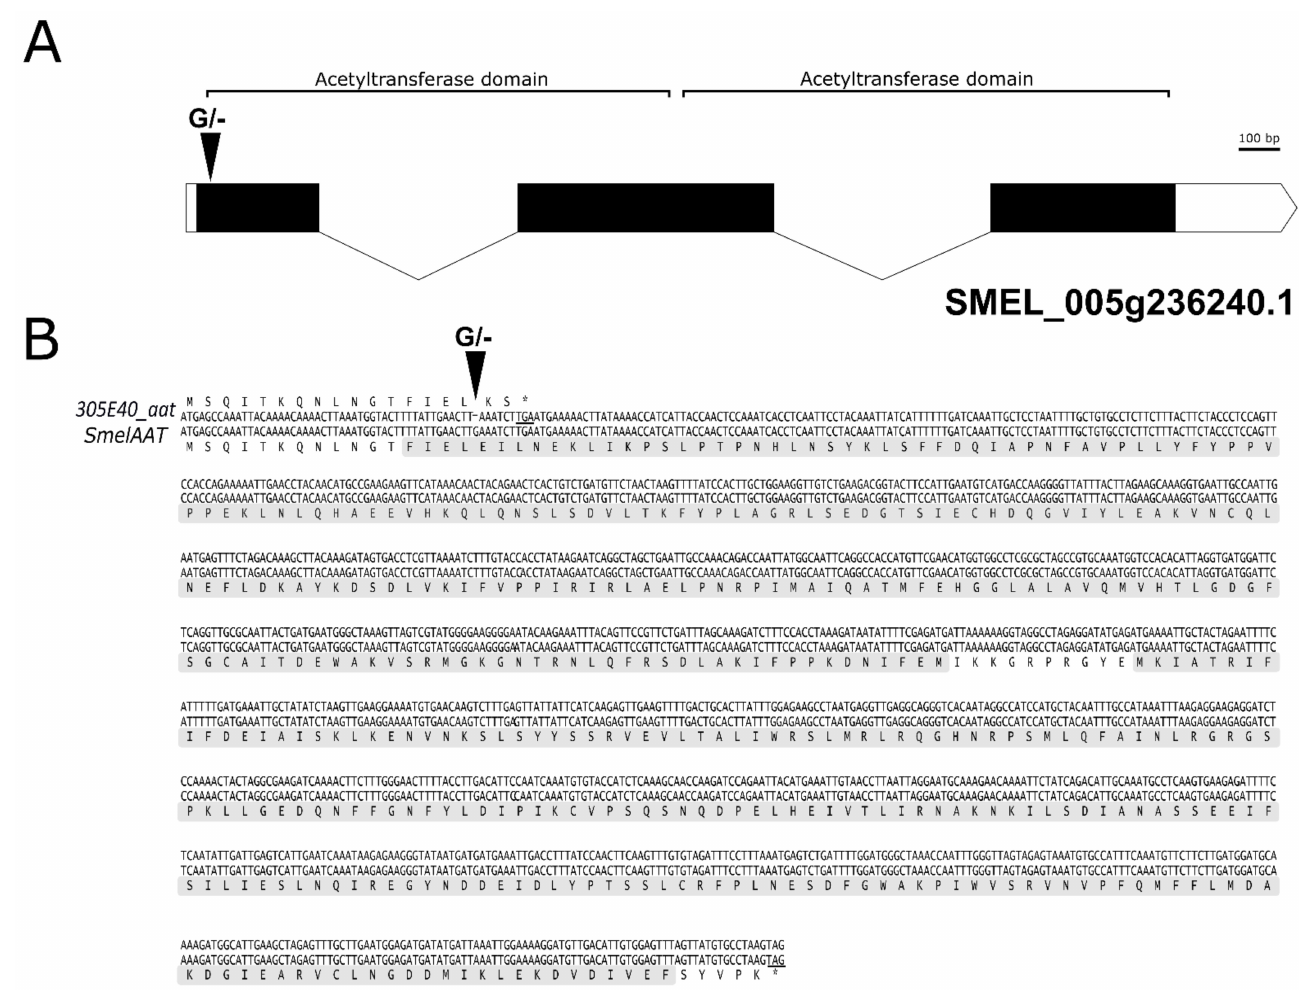
Figure 3. Sequence of the S. melongena 305E40_aat variant and SmelAAT genes. ( A ) Gene structure of SMEL_005g236240.1 ( SmelAAT ). Black solid boxes indicate CDS exons, white boxes indicate UTR regions. Gene portions encoding for the acetyltransferase domains are shown. The arrowhead indicates the position of the identified single-base G deletion. ( B ) Comparison of the CDS and translated amino acidic sequences of SmelAAT and the 305E40_aat allele. Acetyltransferase domains are